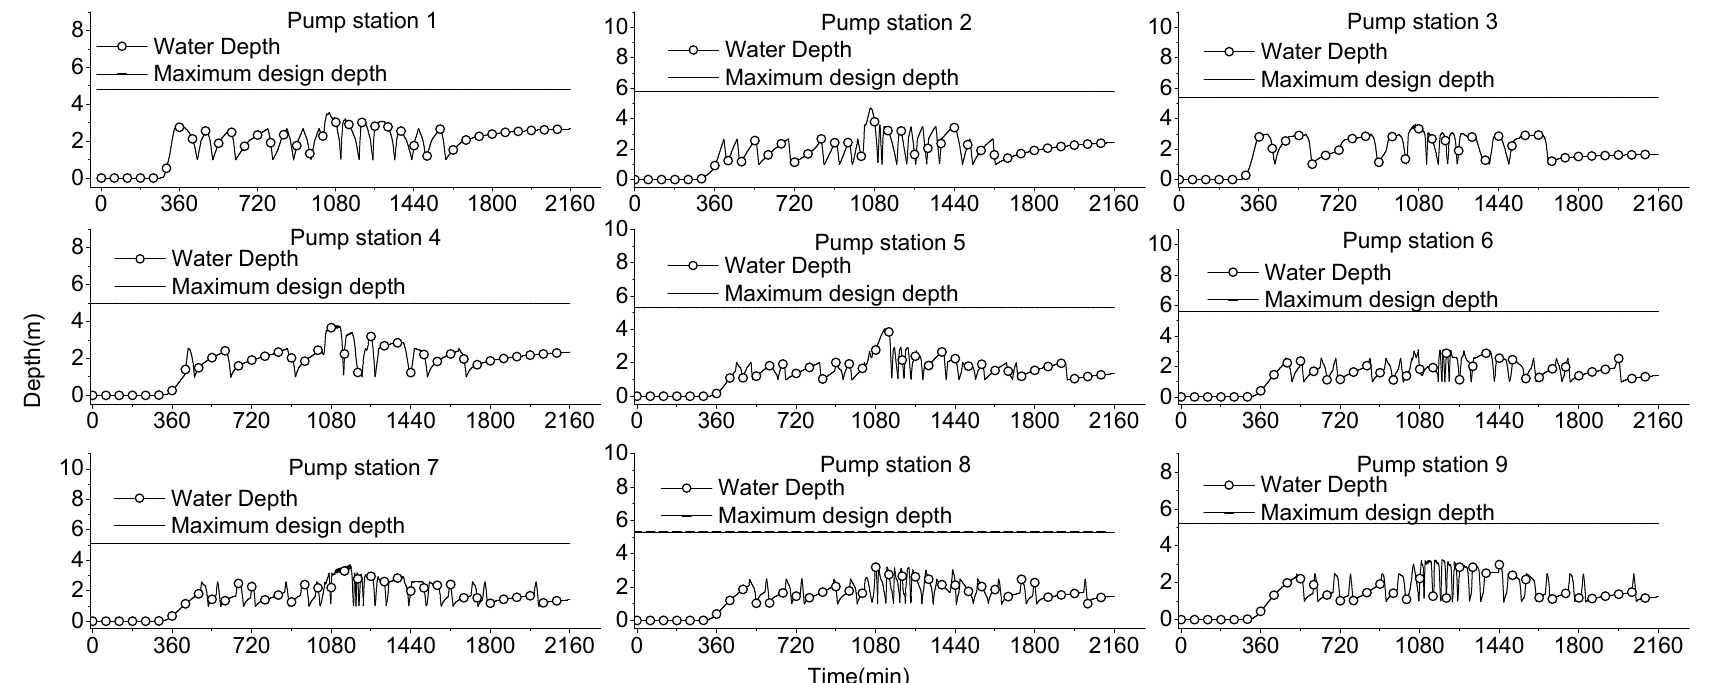
Figure 7. Water depth changing process in the storage tanks for the single pumping station optimization in the twenty-year scenario. Table 3. Pump operation results using the three methods. N is the total number of pump start-up / shuto ff times; T is the total pump operating time (unit: min); 7.21 means rainfall event on 21 July 2012; 7.30 means rainfall event on 30 July 2012; 6.24 means rainfall event on 24 June 2012.